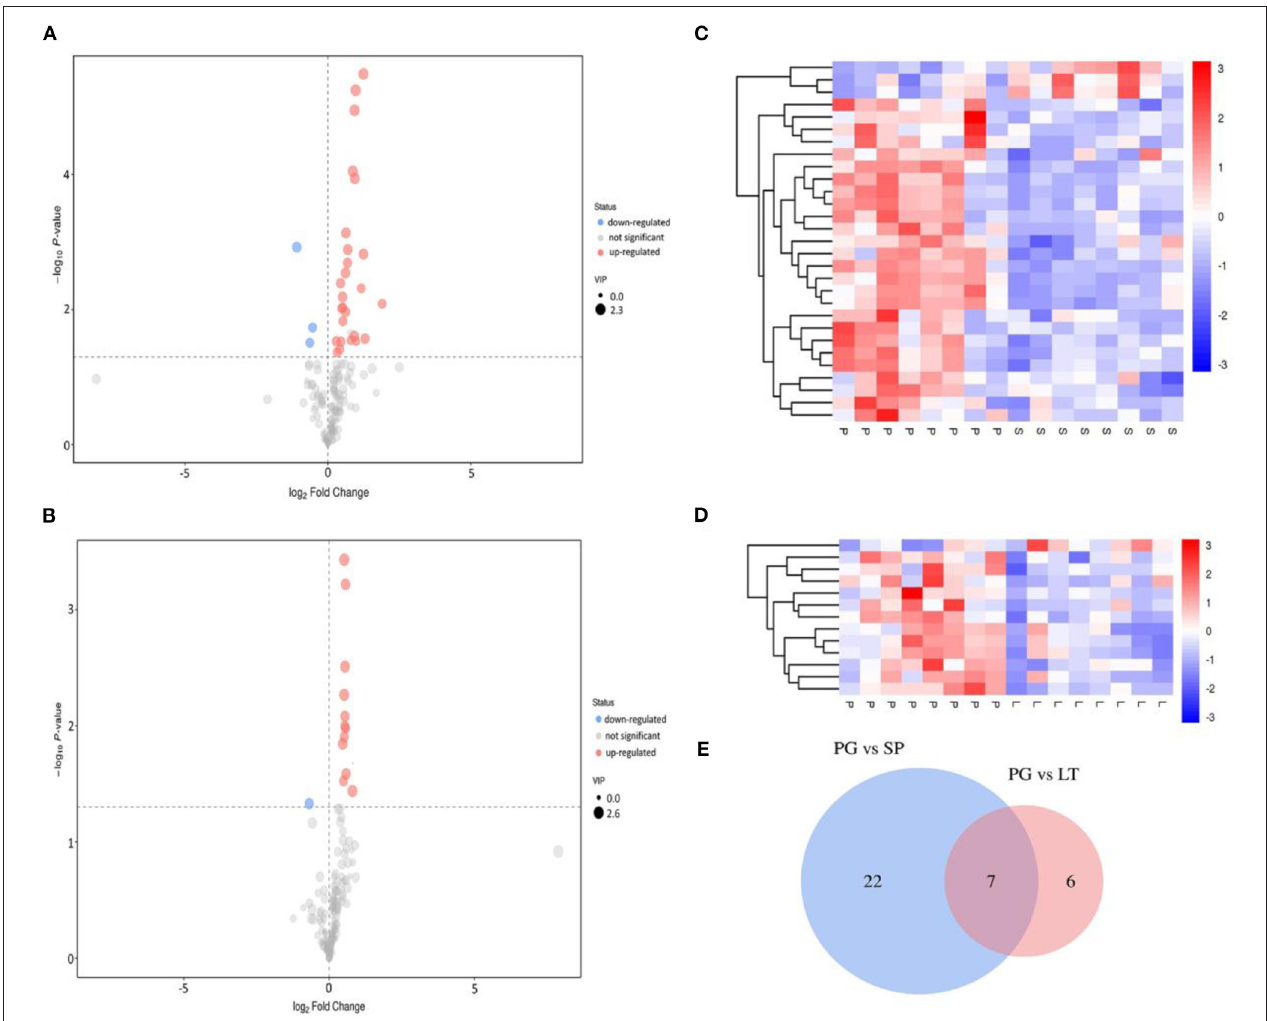
FIGURE 5 | Volcano plot and hierarchical cluster analysis (HCA), and Venn diagram. (A,B) represent the volcano plot showing the differential expression of metabolites between PG and SP, and PG and LT, respectively. The red dots in the figure represent the differentially expressed metabolites that were increased, the blue dots represent the decreased differentially expressed metabolites, and the gray color indicates the differentially expressed metabolites that were not significant. (C,D) represent the heat map showing the differential expression of metabolites between PG and SP, and PG and LT, respectively. The red color indicates the increase in differentially expressed metabolites, while the blue color indicates the decrease in differentially expressed metabolites. (E) is the Venn diagram showing the specific and common differential metabolites between PG and SP, and PG and